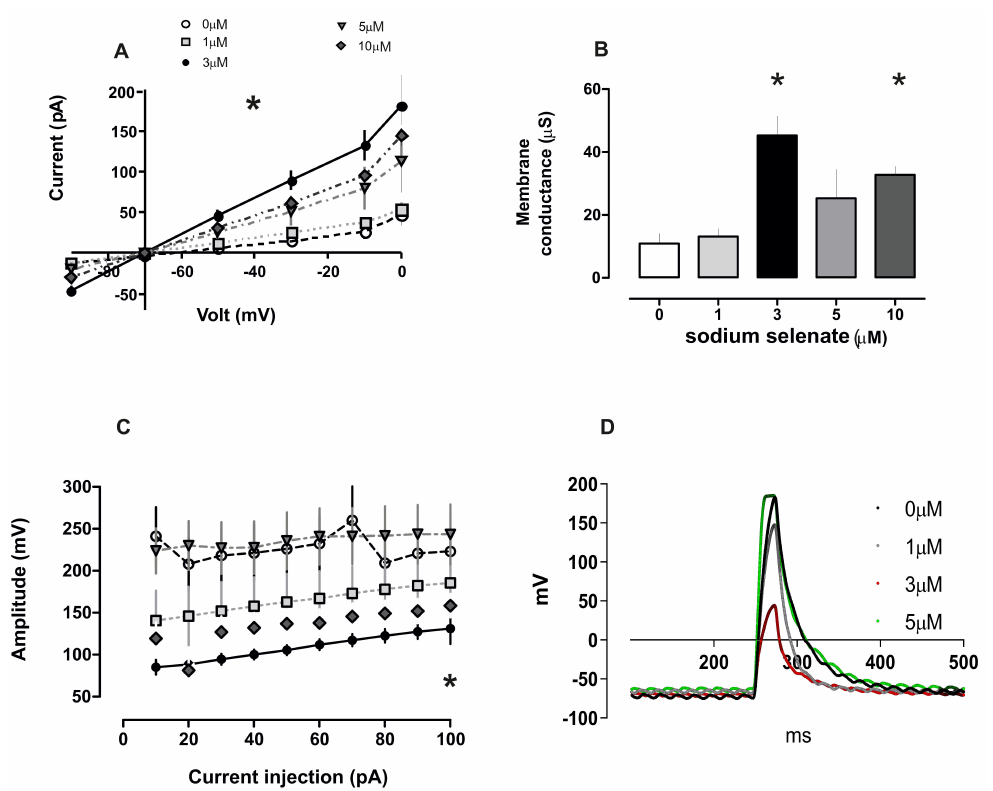
Figure 5. Sodium selenate alters membrane potential and conductance in a dose dependent manner